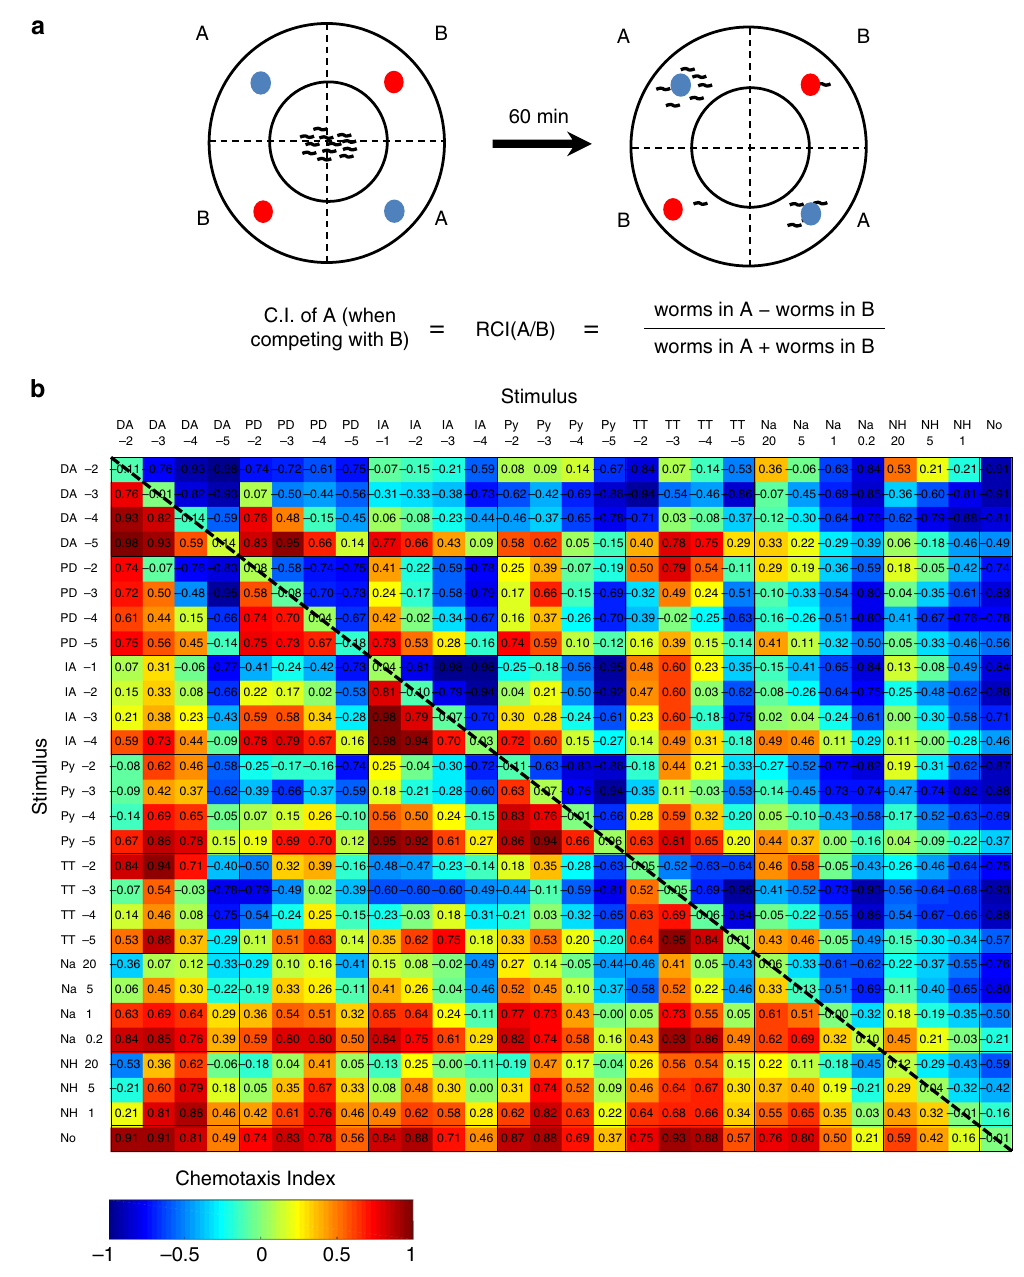
Fig. 1 A comprehensive pairwise preference matrix. a The experimental scheme for the binary choice assay. 100 – 200 worms, placed in the center of a chemotaxis plate, are free to choose between two chemo-attractive options, A and B, each of which is applied at two opposite quadrants. At the end of the experiment, number of worms in each quadrant is counted and the relative preference towards option A vs option B, RCI(A/B), is computed. b All pairwise preference relationships among the 406 binary choice assays (including same option and buffer-only assays). Values inside the entries specify the RCI of the top option relative to the left option. The bottom row depicts preference of each stimulus against a null (buffer) option, denoting the BCIs. Each entry in the matrix is the mean score of 1 – 5 experimental repeats with typically 2 – 3 plates per experiment. The full details of the matrix data set, sample sizes, and statistics are provided in Supplementary Table 1. DA, diacetyl; PD, 2,3-pentanedione; IA, iso-amyl alcohol; Py, pyrazine; TT, 2,4,5-trimethylthiazole; Na, NaCl; NH, NH 4 Ac . ‘ No ’ indicates a null (buffer) option. For volatile cues (DA, PD, IA, Py, and TT), numbers in the top and side labels specify the exponent of the 10 x dilutions. For salts, the numbers represent molar concentrations (see us to provide a more accurate classi fi cation of the various triple transitivity were more frequent in triplets consisted of odorants sets (see methods and Supplementary Fig. 4). We found that only, rather than in triplets consisted of both odorants and 351 triplets could be classi fi ed with statistical signi fi cance tastants (Fig. 3d – e, p < 0.01, Χ 2 test). Notably, while our (Fig. 3b), of which 243 triplets were heterogeneous, (i.e., analyses indicate that the fraction of total intransitive cases is consisted of three different types of options, Fig. 3c). Interest- ~10 – 15%, this percentage greatly depends on the speci fi c set of ingly, only a small fraction (3%) of these 243 heterogeneous stimuli used to construct the matrix, as well as on the statistical triplets were fully intransitive. Furthermore, violations of power for inferring (in)transitivity.